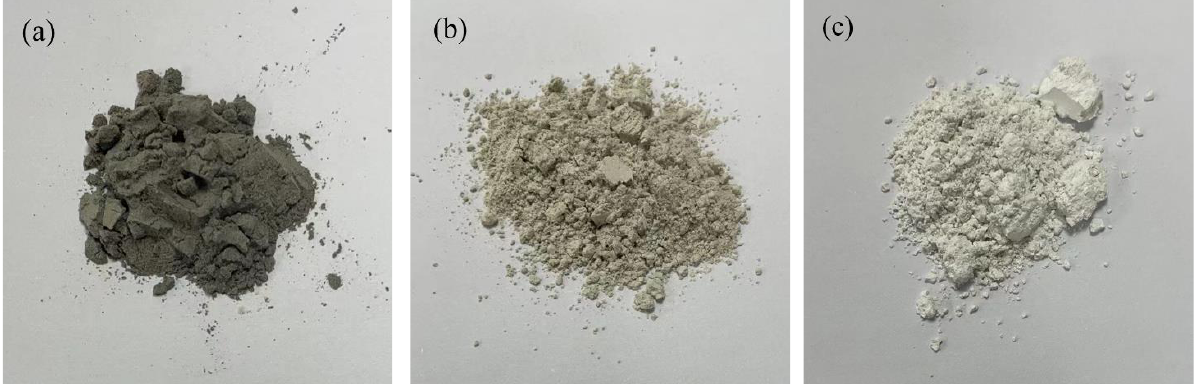
Metals 2022 , 12 , x FOR PEER REVIEW Figure 1. Photos of raw materials: ( a ) CFA; ( b ) FGD; and ( c ) SCS. Figure 1. Photos of raw materials: ( a ) CFA; ( b ) FGD; and ( c ) SCS.